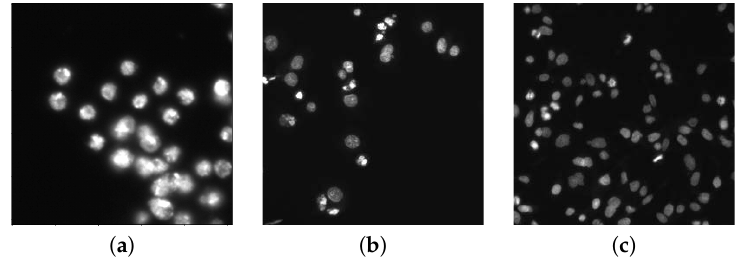
Figure 2. ( a – c ) Examples of the analyzed microscopy fluorescence from the DSB dataset.